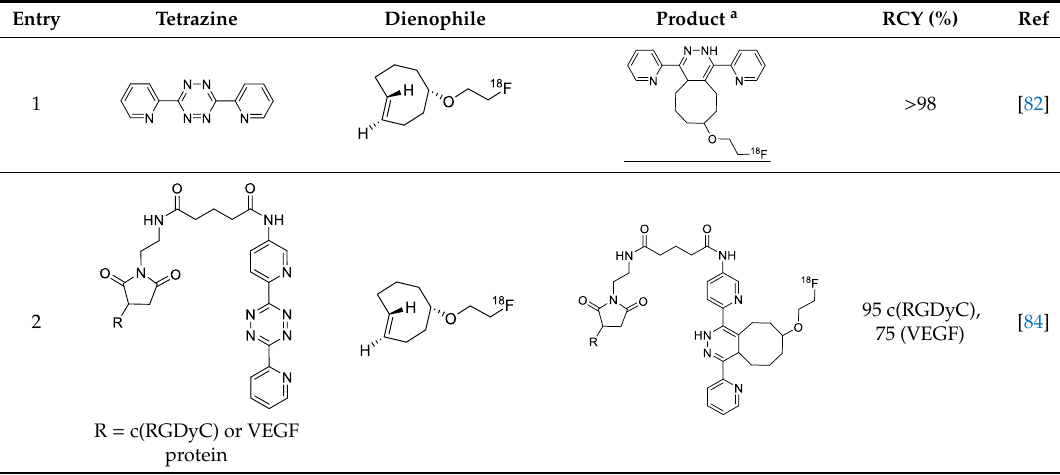
Figure 9. Radiolabeling of tetrazine conjugated cRGD peptide using 18 F-labeled TCO; a ) DMSO, 10 s, room temperature.